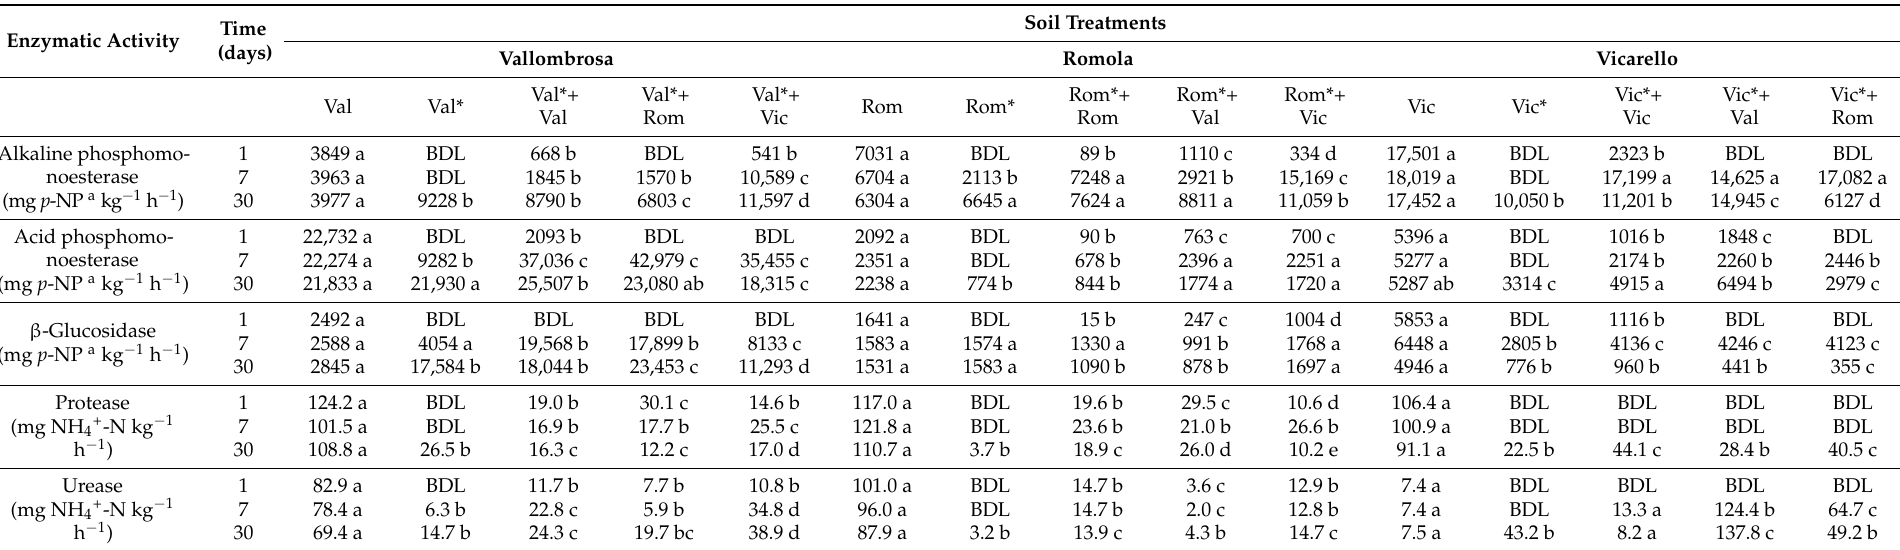
Table 2. Enzymatic activities in self- or cross-reinoculated heat-sterilized soils during a 30 d incubation experiment. Heat-sterilized and non-inoculated soils (Val*, Rom*, Vic*) together with non-heat-sterilized and non-reinoculated soils (Val, Rom, Vic) were taken as control treatments. At each sampling time, different letters indicate a significant ( p < 0.05) difference among means (n =